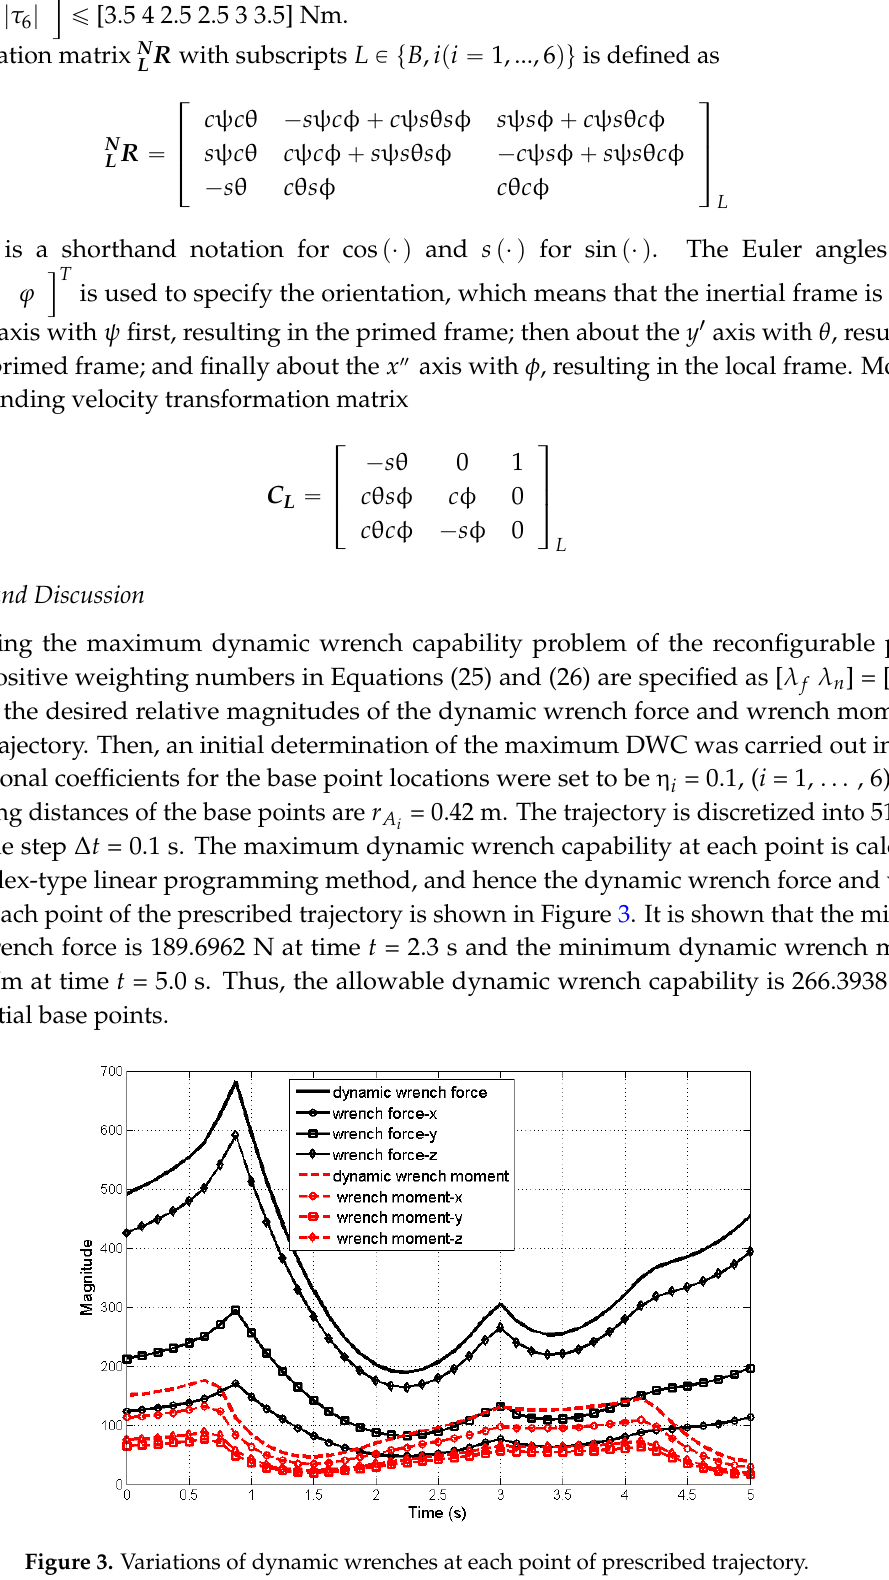
Figure 3. Variations of dynamic wrenches at each point of prescribed trajectory.